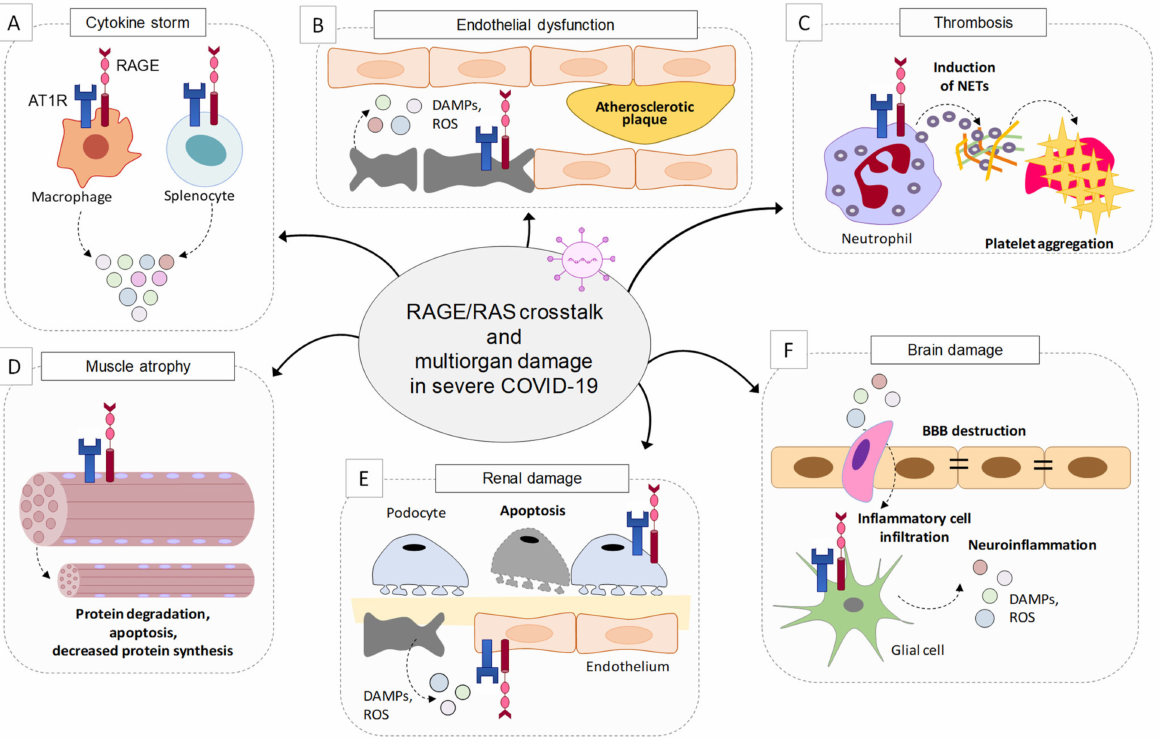
Figure 2. RAGE/RAS crosstalk might take place in several tissues sustaining multiorgan damage in severe COVID-19 conditions. RAGE/RAS signaling might ( A ) sustain cytokine storm in macrophages and splenocytes; ( B ) induce endothelial dysfunction by increasing capillary permeability, the release of damage-associated molecular pattern molecules (DAMPs), and reactive-oxygen species (ROS) production, leading to atherosclerotic plaque formation; ( C ) predispose to thrombosis by inducing the formation and release of neutrophil extracellular traps (NETs) by neutrophils and subsequent platelet aggregation; ( D ) induce muscle atrophy by stimulating apoptosis, increasing protein degradation, and reducing protein synthesis; ( E ) sustain renal damage by inducing podocyte apoptosis and endothelial dysfunction; and ( F ) induce brain damage by altering the blood-brain barrier (BBB) favoring the entry of immune cells, and